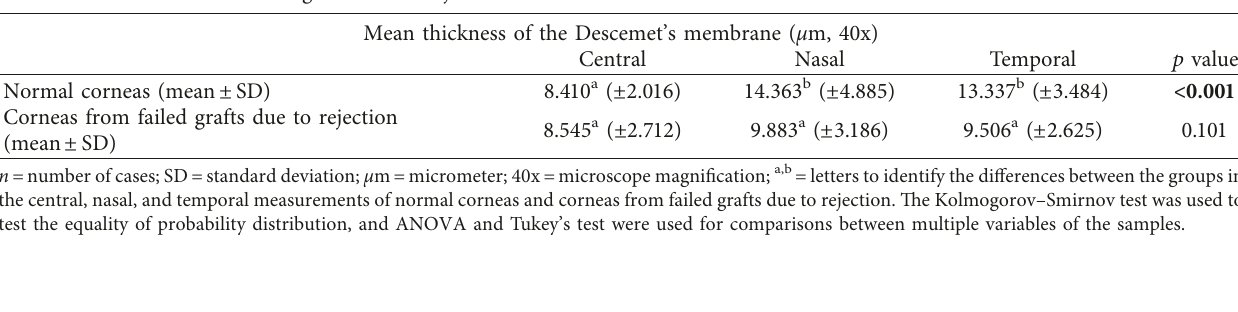
Table 3: Internal validation: comparison between corneal measurements obtained from manual microscopy only and digital microscopy on 10 normal corneas stained with periodic acid-Schiff (PAS). Corneal measurements Manual microscopy Digital